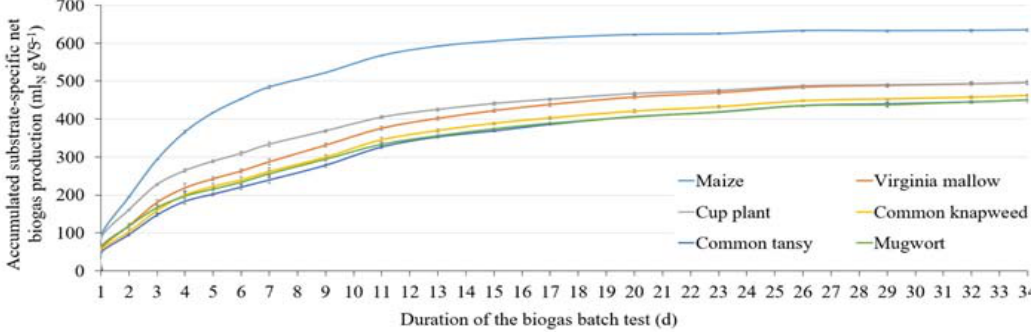
Figure 4. Accumulated substrate-specific net biogas production of the crops investigated in this study. For each measurement and for each crop except mugwort, the error bars indicate the standard deviation for the replicates of the crop species in the field trial.